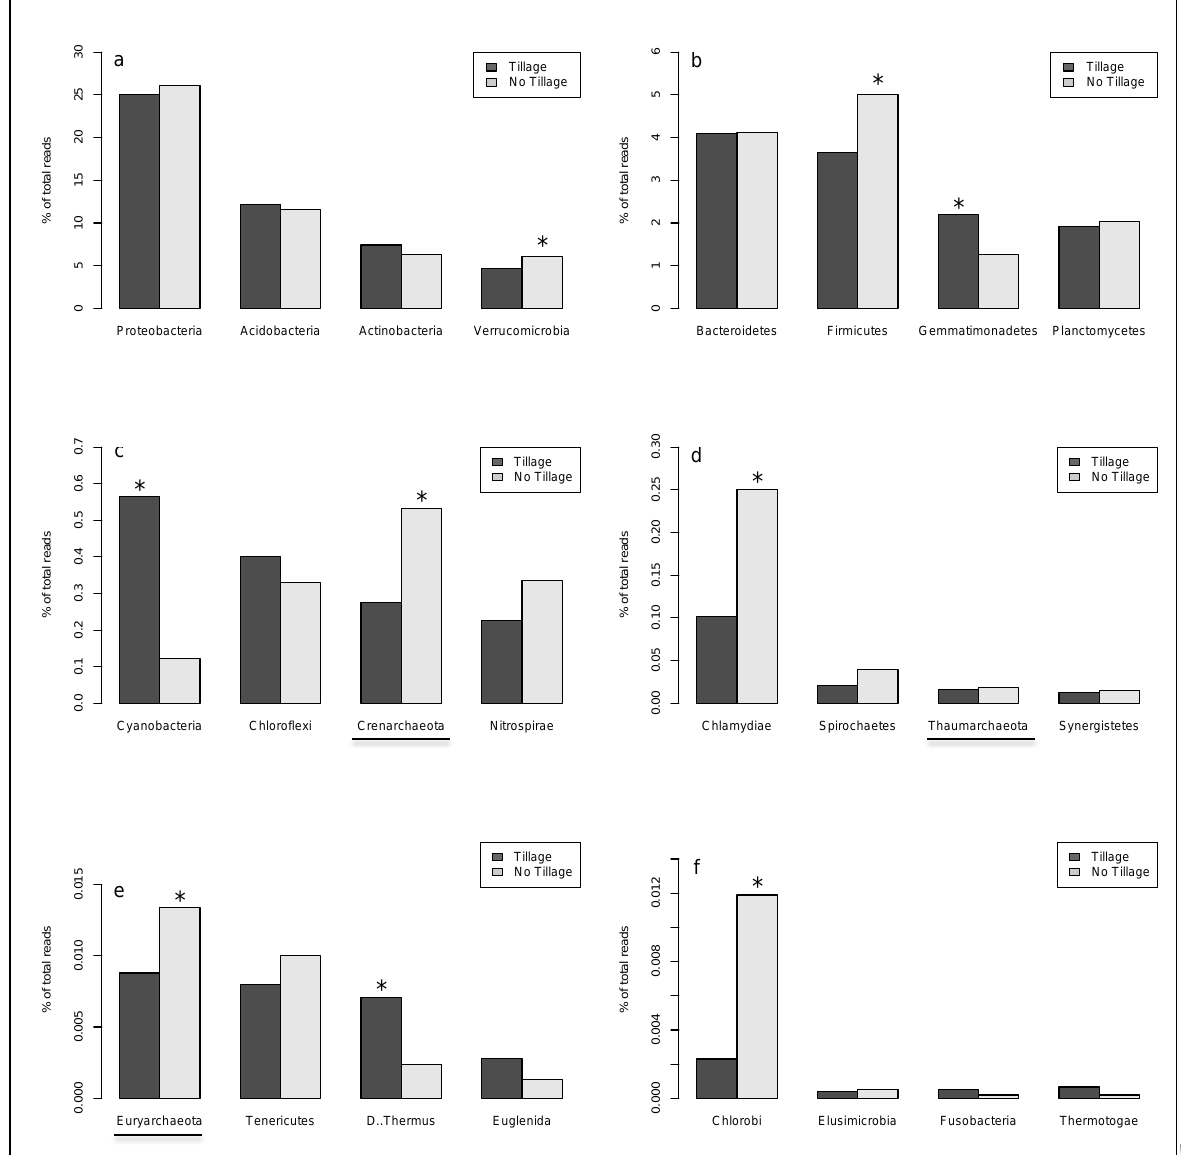
Figure 1. Relative abundance of 16S rRNA gene (% of total reads) to phylum level, in an Acrisol under conventional tillage and no-tillage soil management. Asterisk expresses that the average differs statistically by Tukey test, at p-value ≤ 0,01. The archaeal phyla are underlined.